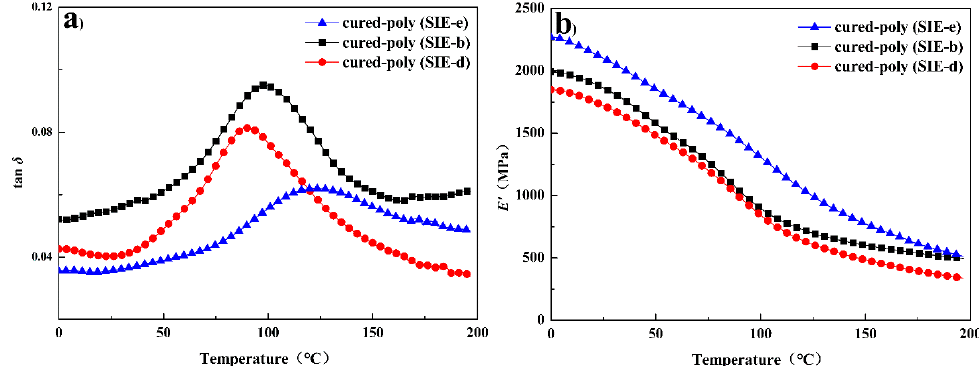
Figure 11. DMA curves for the cured benzoxazine oligomers: ( a ) tan δ of the bio-based cured benzoxazine polymers; ( b ) E’ of the bio-based cured benzoxazine polymers.